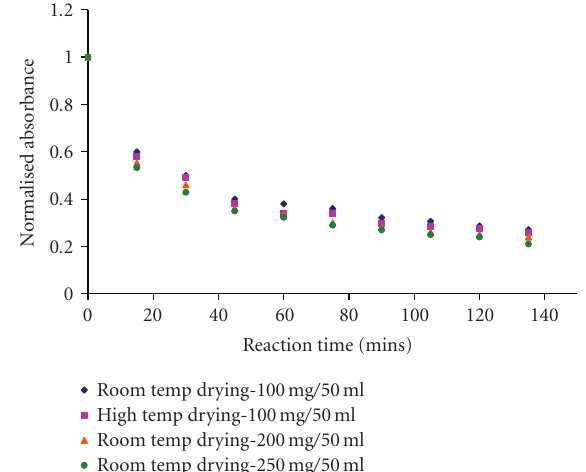
di ff erent coatings using the slurry method described above.